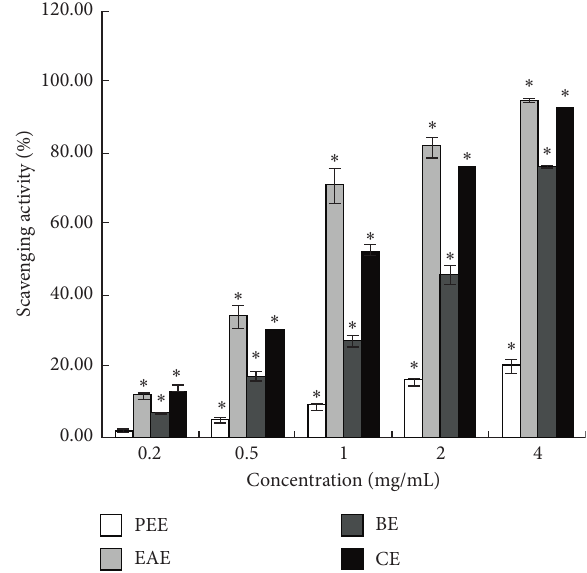
Figure 1: DPPH radical scavenging activity (%) of four extracts. ∗ P < 0 . 05 vs. the blank group.